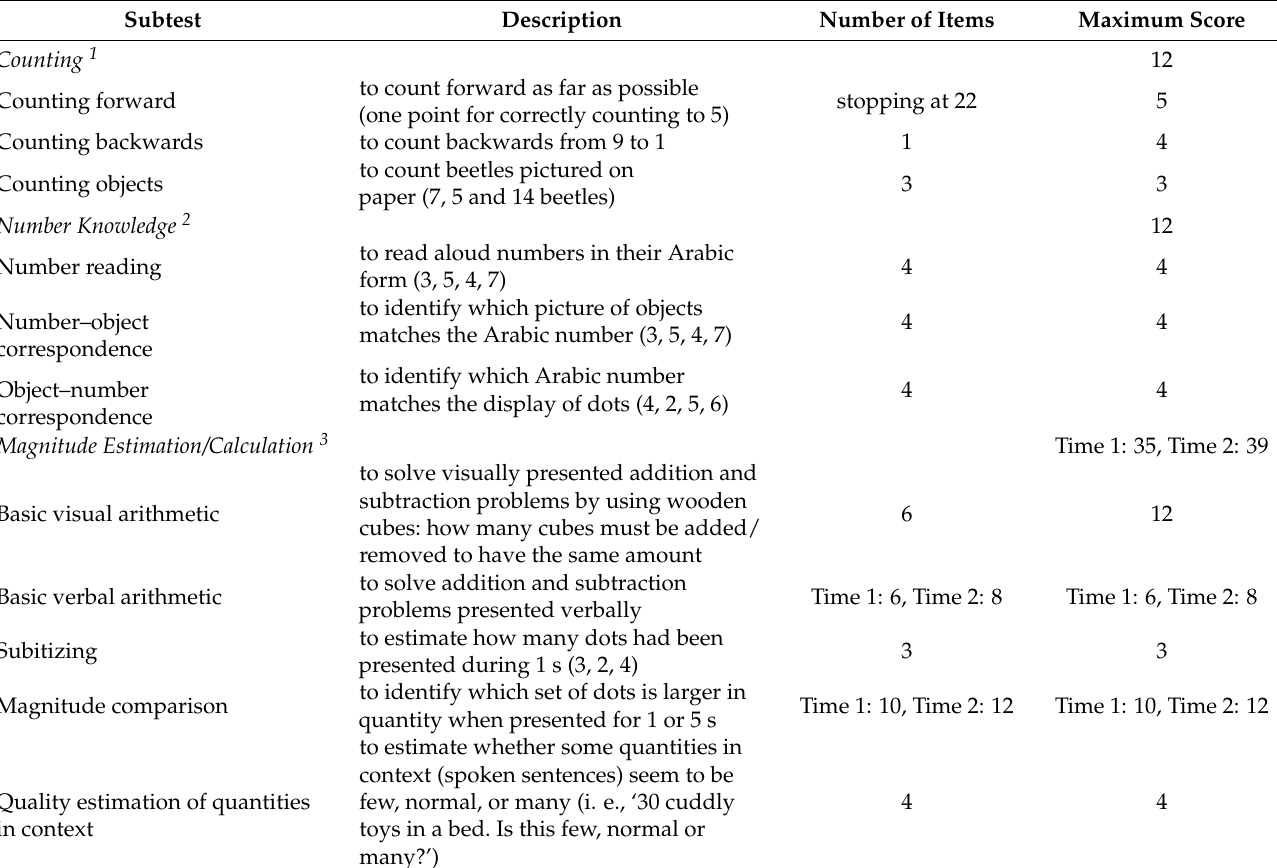
Table 1. Descriptions of numerical and basic arithmetical subtests at Time 1 and Time